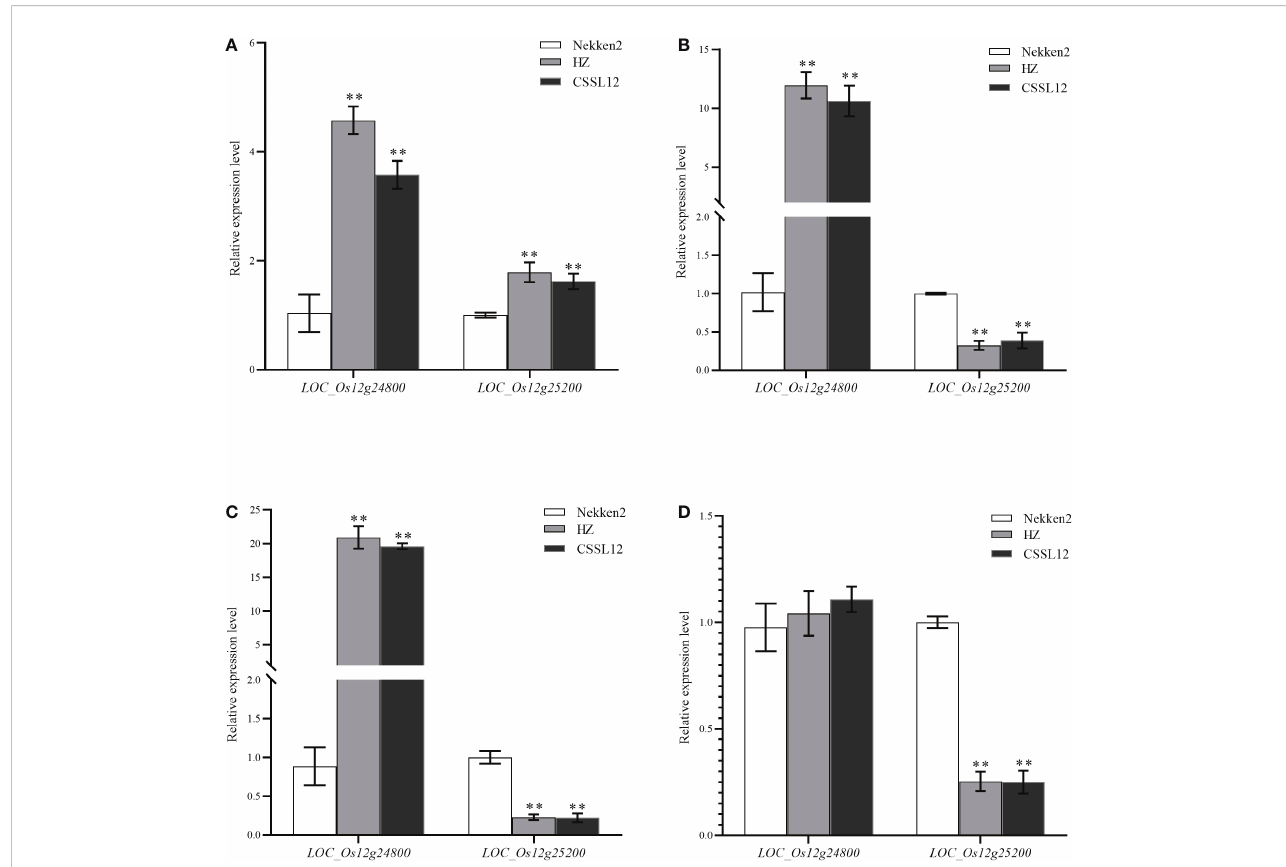
FIGURE 8 The qRT-PCR analysis of predicted genes in Nekken2, HZ and CSSL12. (A) Expression of candidate genes at 0 mM NaCl concentration. (B) Expression of candidate genes at 60 mM NaCl concentration. (C) Expression of candidate genes at 80 mM NaCl concentration. (D) Expression of candidate genes at 100 mM NaCl concentration. * indicates signi fi cance at P ≤ 0.05 by Student ’ s t test, ** indicates signi fi cance at P ≤ 0.01 by Student ’ s t